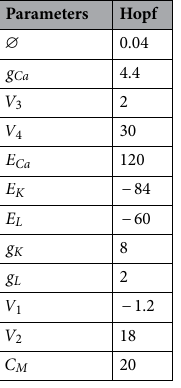
Table 1. M–L equation